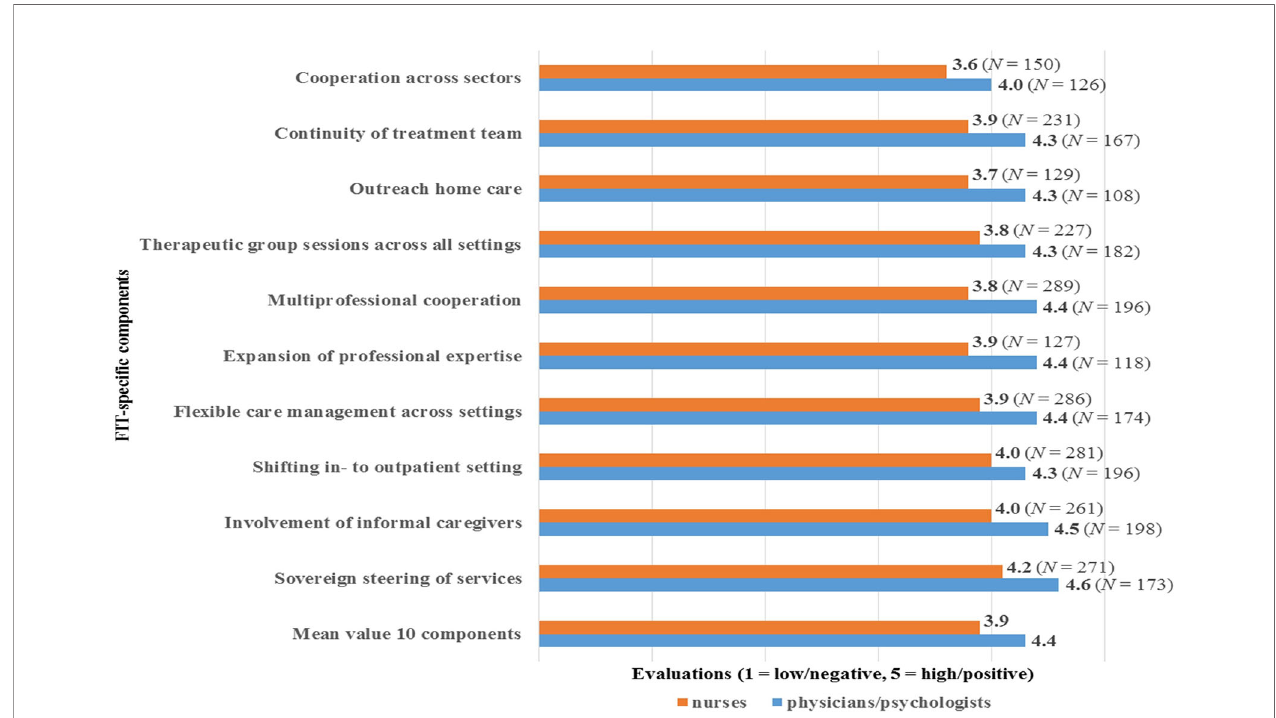
FIGURE 2 | Evaluations of FIT-components (EV) by physicians/psychologists ( N = 211) and nurses ( N =